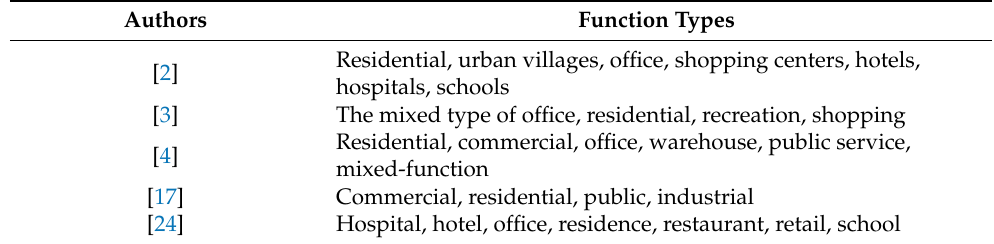
Table 2. Building function type classification schemes used in past